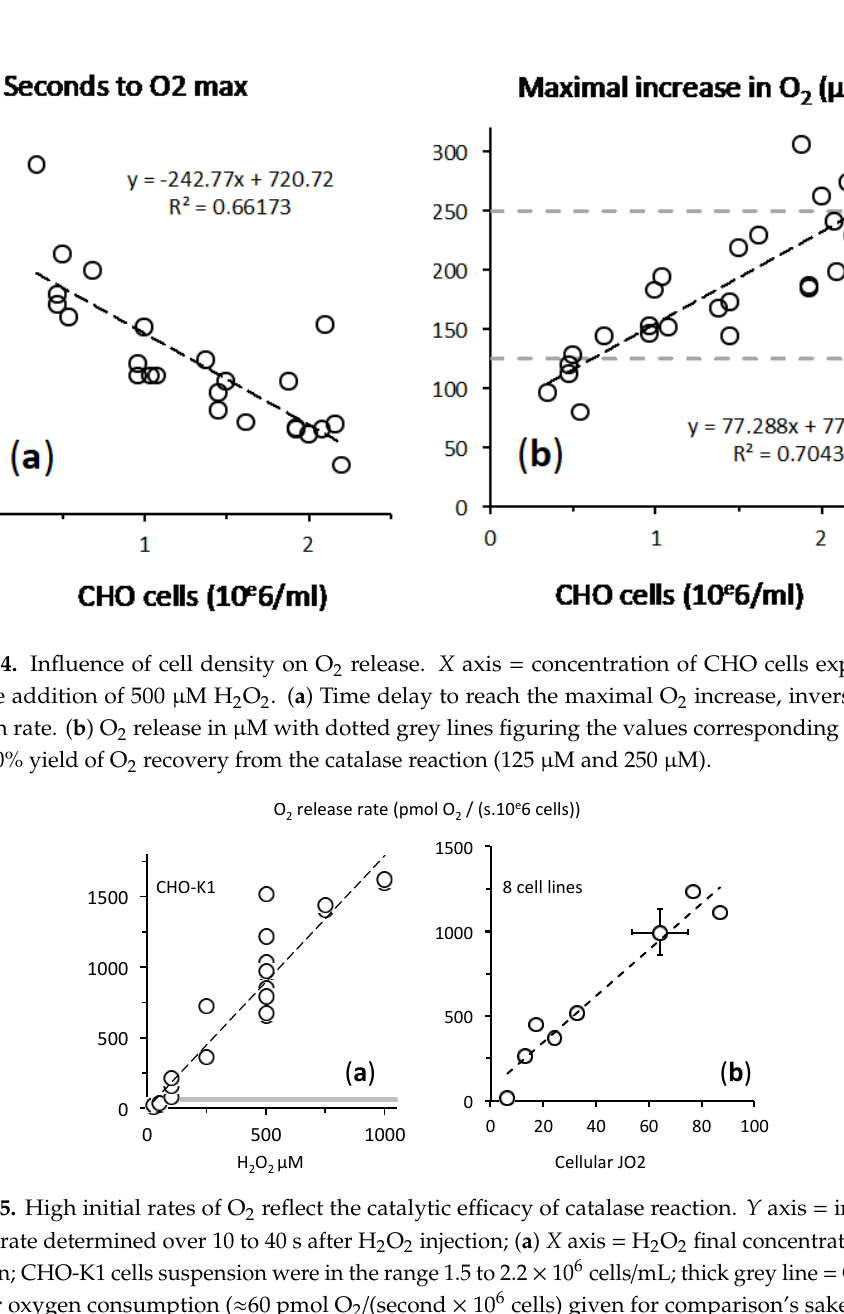
Figure 6. Evaluation of cellular oxidative stress using the aconitase to fumarase ratio in CHO cells exposed to H 2 O 2 . Y axis = aconitase to fumarase ratio; X axis = H 2 O 2 concentration. ( a ) Empty bars =